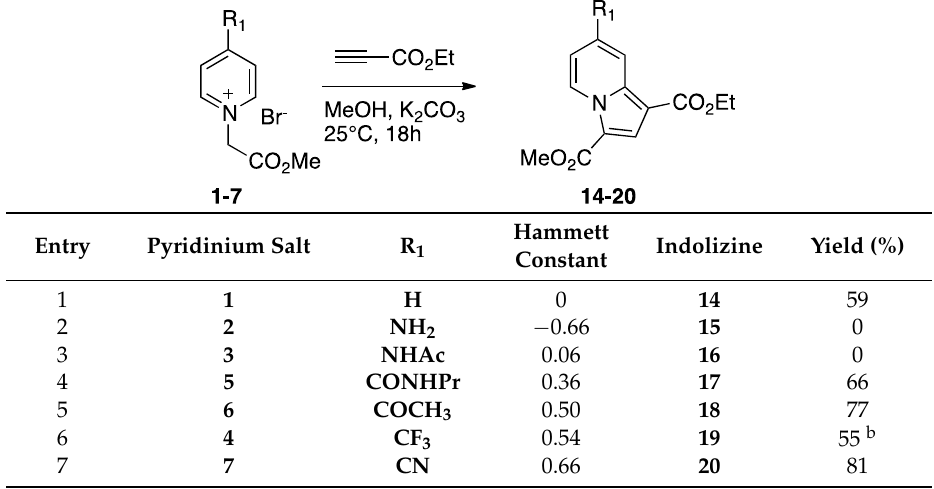
Molecules 2016 , 21 , 332 Table 2. Influence of the pyridine substituent R 1 on the yields of indolizines a .